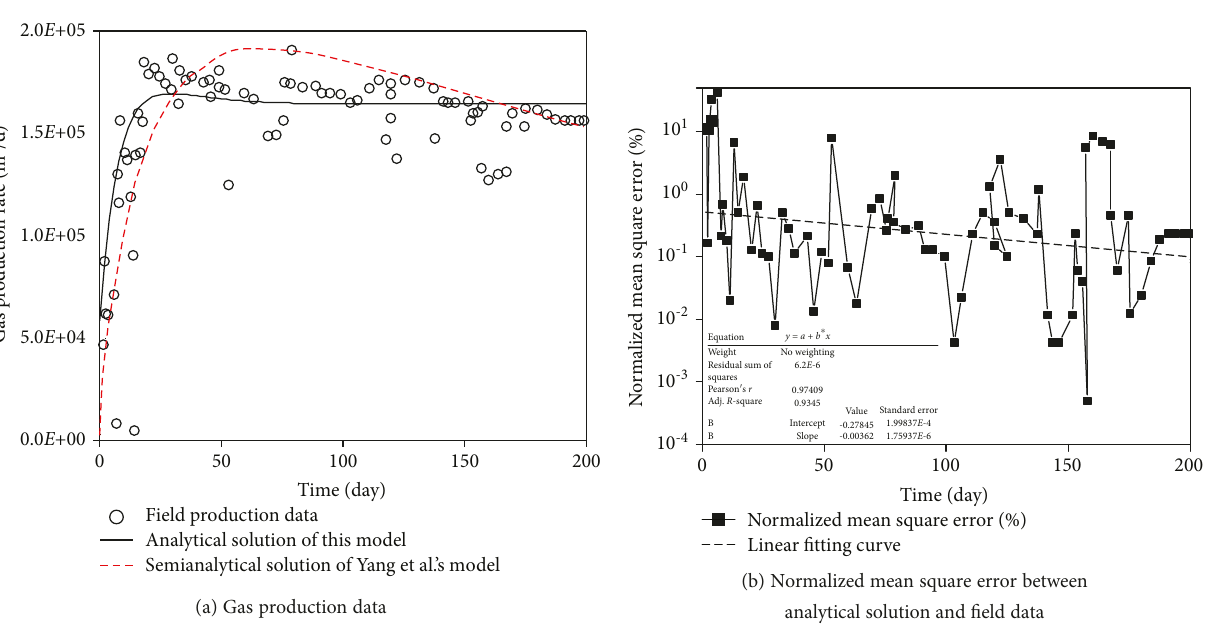
Figure 3: Model veri fi cations of gas production in the fl owback period of a China shale